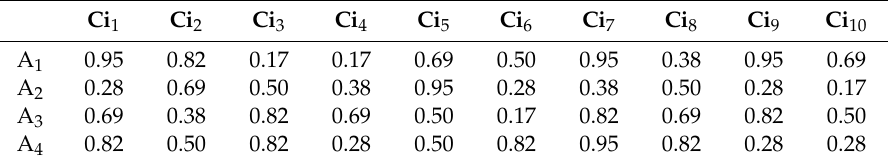
Table 18. Deneutrosophication values of the judgments matrix.